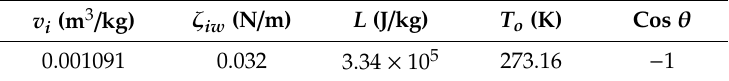
Table 2. Parameters for calculating pore size and pore water freezing